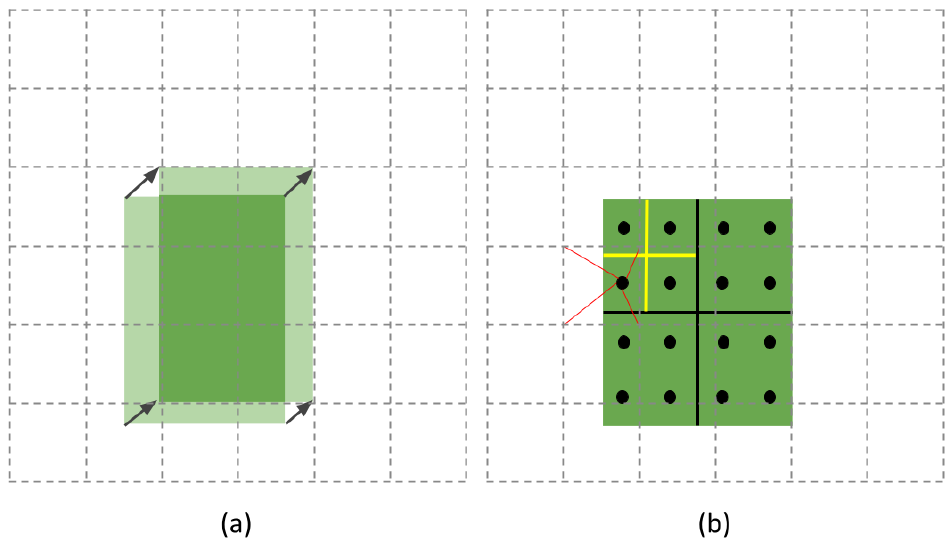
Figure 3. From Fast R-CNN to Mask R-CNN: ( a ) RoI-pooling layer and ( b ) RoIAlign layer. Faster R-CNN was extended by the Mask R-CNN [9] with a branch to perform a pixel-level object instance segmentation by predicting an object mask in parallel with the segmentation masks on each RoI (Region of Interest) for bounding box recognition. To